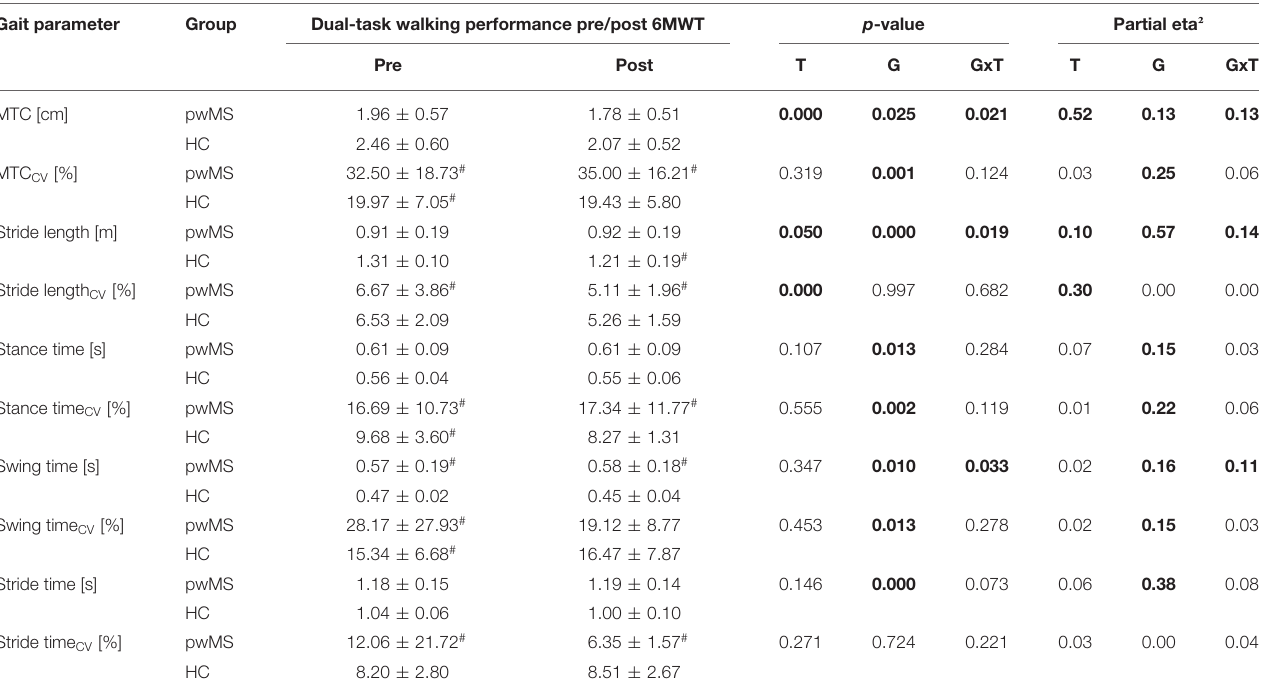
the stance time ( p = 0.107; η p ² = 0.07), the time effect was non-significant but a medium effect size was present. Group effects were shown for all the spatio-temporal gait parameters ( p < 0.05; η p ² = 0.13–0.57) except stride length CV and stride time CV